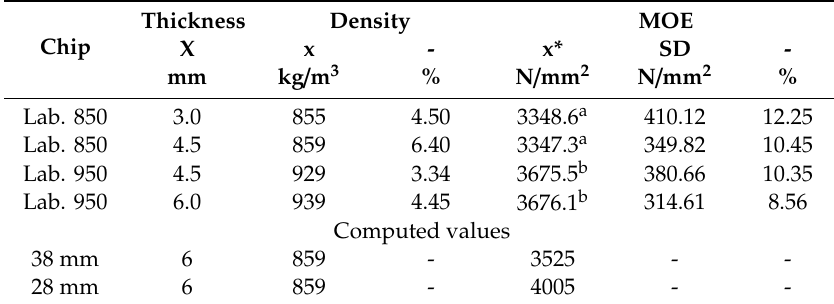
Table 6. Physical and mechanical properties of one-ply laboratory boards made from microchips and face layers typical for industrial boards with nominal thickness of 38 mm and 28